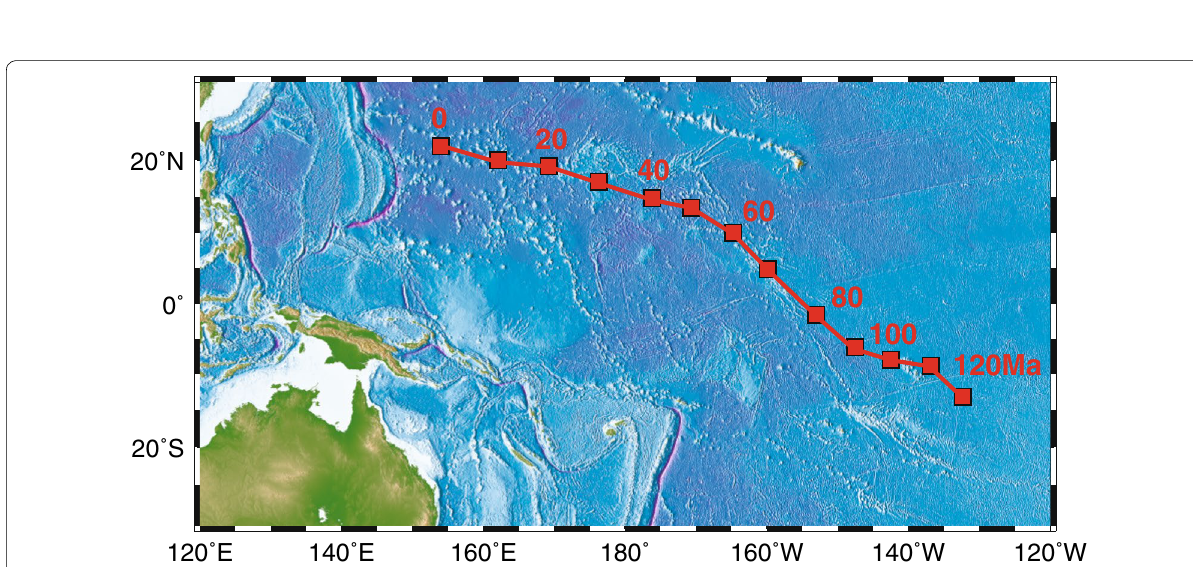
Fig. 10 Paleopositions of the core KR13-02 PC06 site superimposed on the present-day bathymetry. The backtrack path was calculated with the GPlates software (Seton et al.